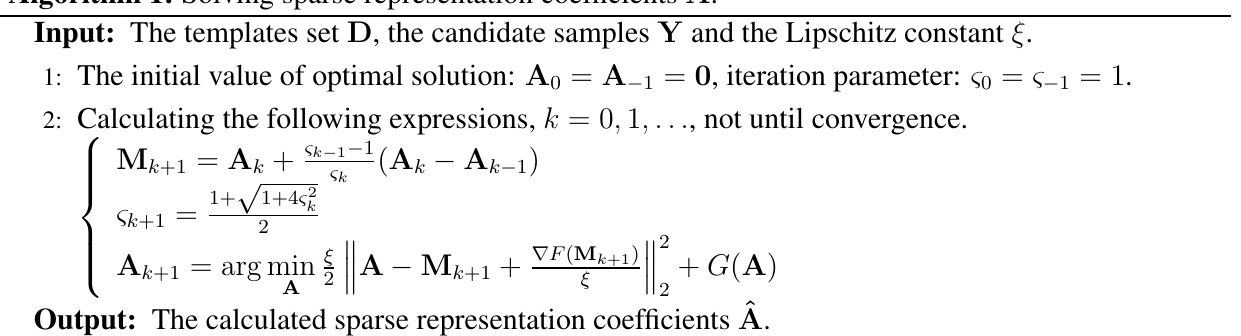
Algorithm 1: Solving sparse representation coefficients A